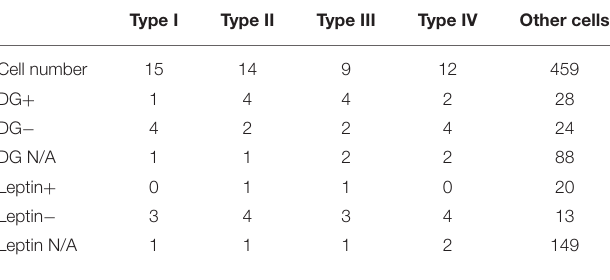
TABLE 1 | Statistical features of all types of FRNs.